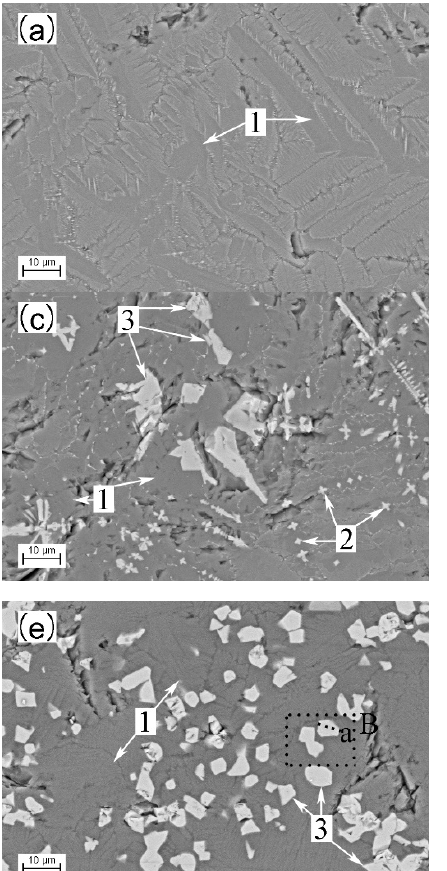
Figure 1. XRD analysis results of adding different Cr 2 O 3 content to CaO-SiO 2 -Fe t O system.